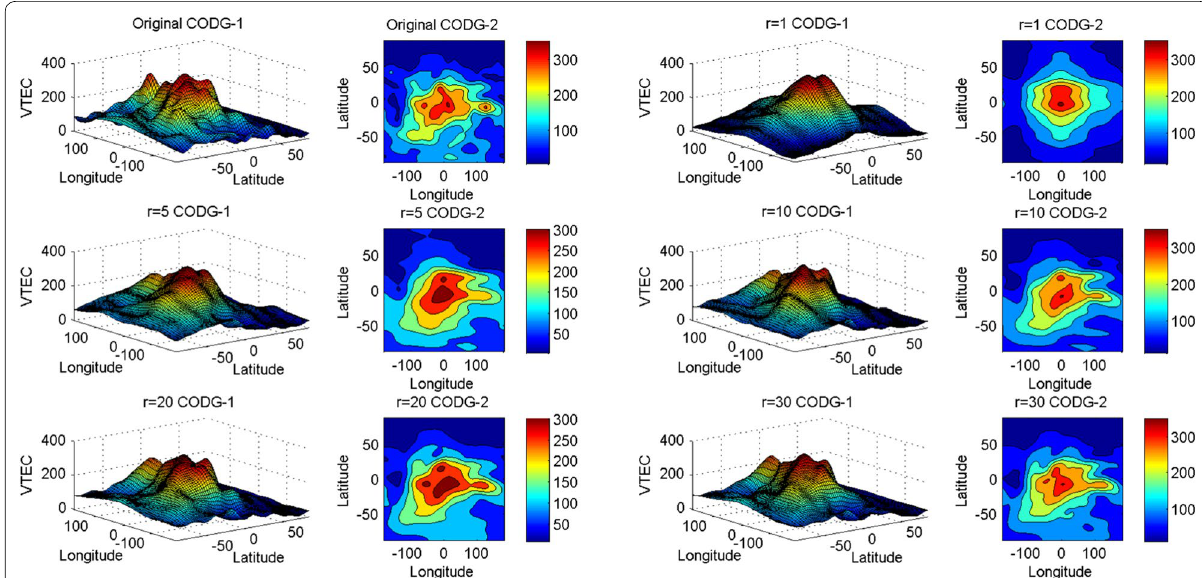
Fig. 1 The original ionospheric VTEC map for 14 : 00 − 16 : 00 UT on January 1, 2011 and its corresponding tensor rank decomposition, r = 1 , 5, 10, 20, and 30. The labels, ‘ − 1 ’ and ‘ − 2 ’, represent the surface and contour plots, respectively. The geographic longitude ranges from − 180 ◦ to 180 ◦ . The geographic latitude ranges from − 87.5 ◦ to 87.5 ◦ . The units of VTEC are in 0.1